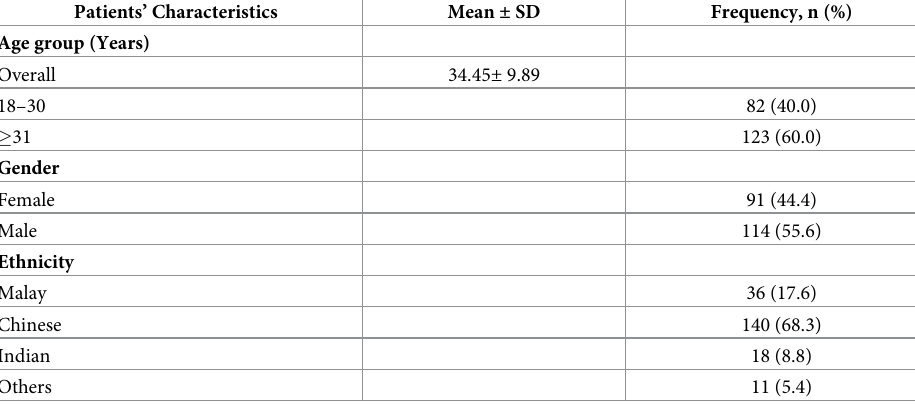
Table 2. Demography characteristics of AP patients (n =